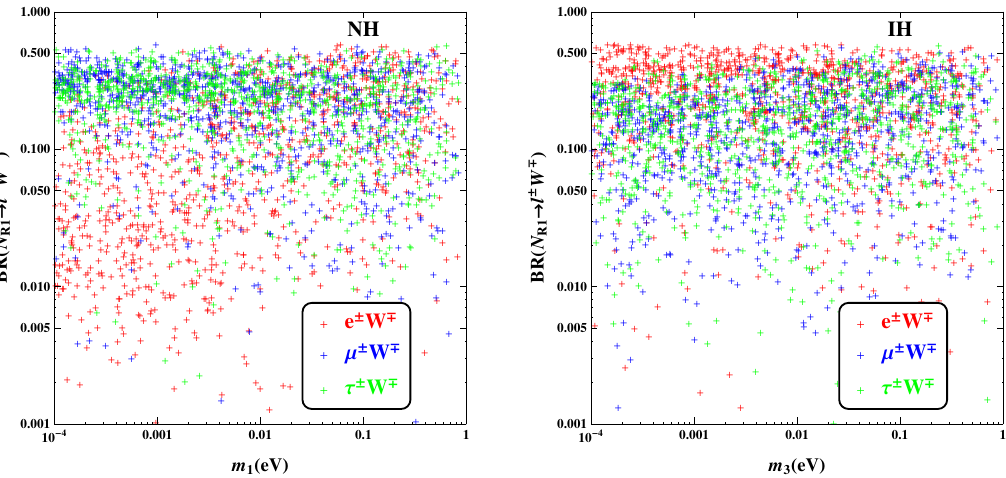
Figure 5 . Branching ratios of N R 1 into ‘ (cid:6) W (cid:7) as a function of the lightest neutrino mass for normal (left panel) and inverted (right) hierarchy at m N